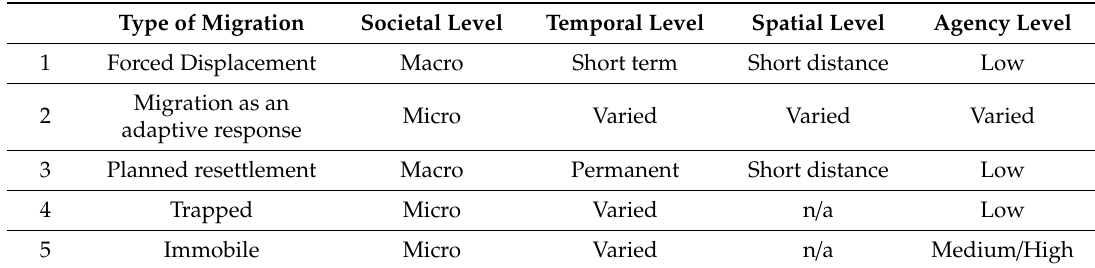
Table 1. Summary of the five categories of migration and their general qualities defined in terms of societal, temporal, spatial and agency